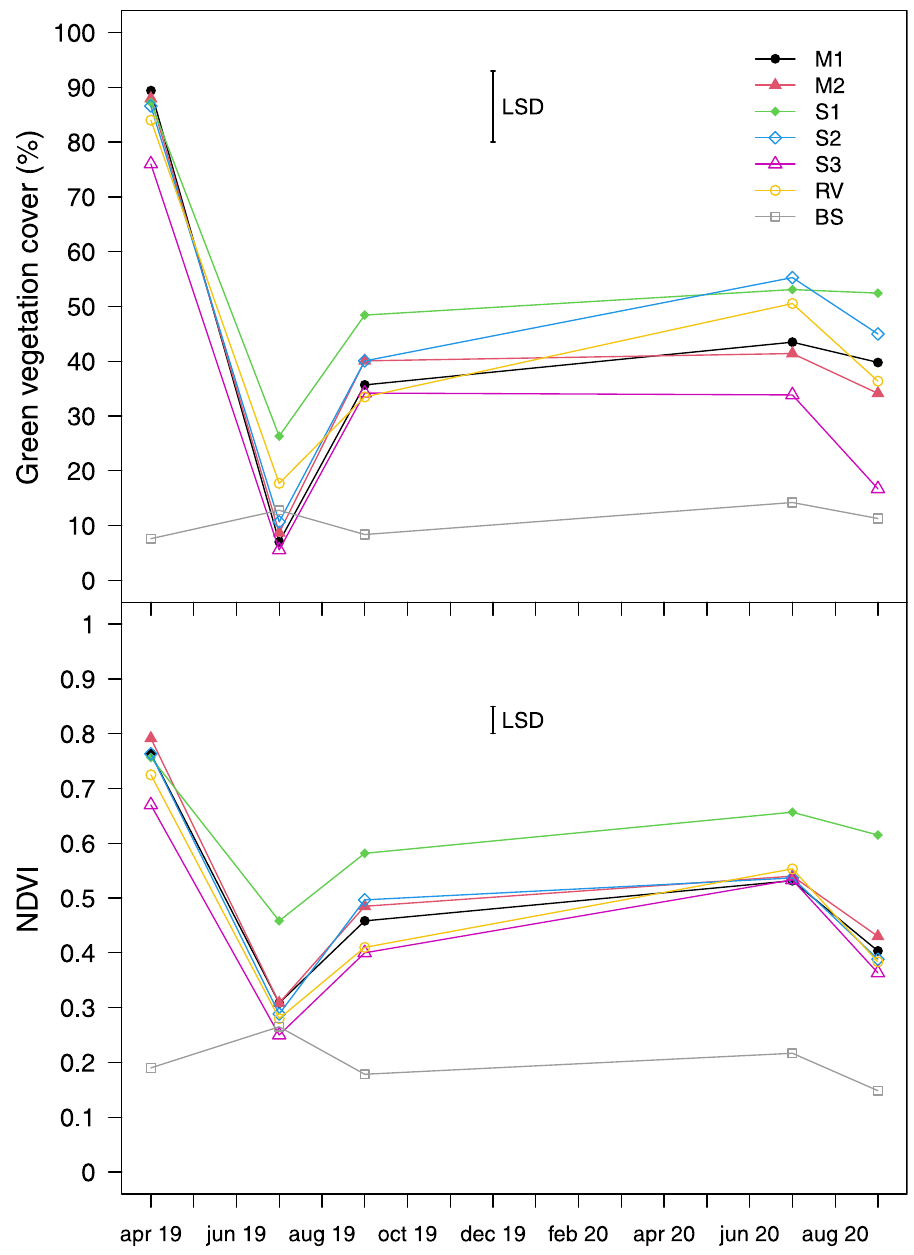
Fig 4. Effects of sampling date on the percentage green cover and NDVI of inter-row vegetation types (M1 = grass-legume mixture 1, M2 = grass-legume mixture 2, S1 = Schedonorus arundinaceus blend, S2 = Lolium perenne blend, S3 = Festuca rubra blend, RV = resident vegetation) and bare soil (BS). The vertical bars represent least significant differences (LSD) at a 0.05 probability